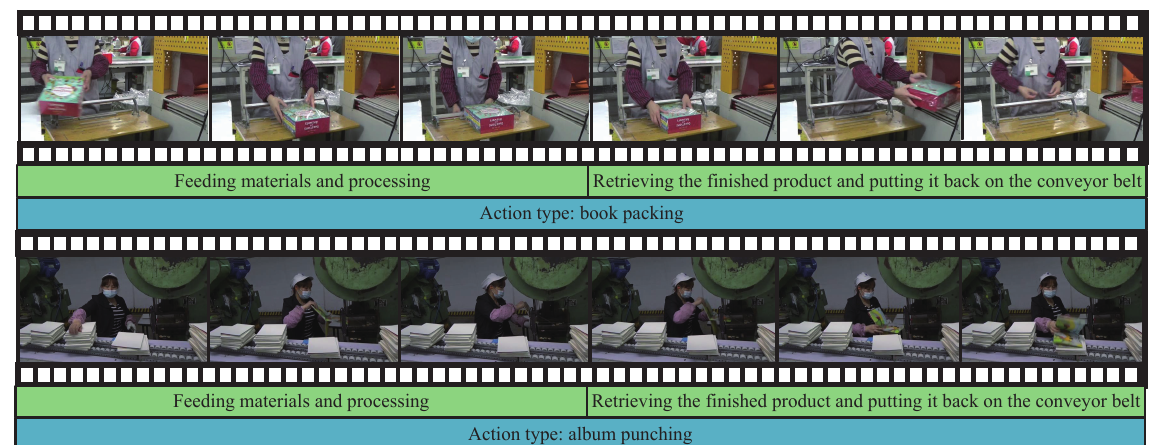
Figure 2. Key gestures for package printing production line